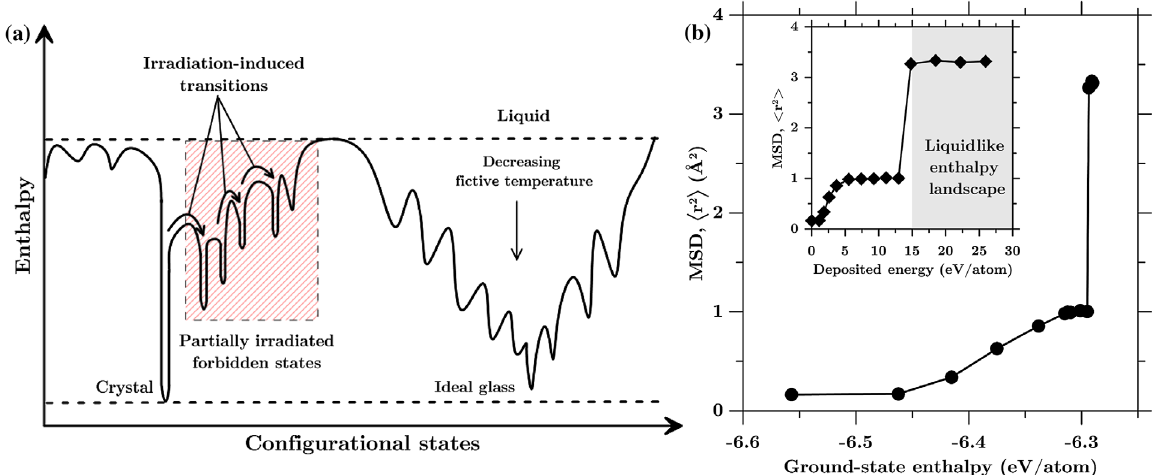
FIG. 4. Topography of the enthalpy landscape. (a) Schematic of the enthalpy landscape explored upon irradiation. The x axis represents all the configurational states. The red box indicates the extent of the forbidden region that is not accessible by conventional thermal pathways. (b) Atomic MSD explored by the atoms during 100 ps of dynamics following a similar energy bump in pristine, partially irradiated, and fully irradiated quartz samples with respect to the ground-state enthalpy. The inset shows the same values of MSD with respect to the deposited energy. The shaded region indicates the extent of the liquidlike region of the enthalpy landscape, for which irradiation-induced damage